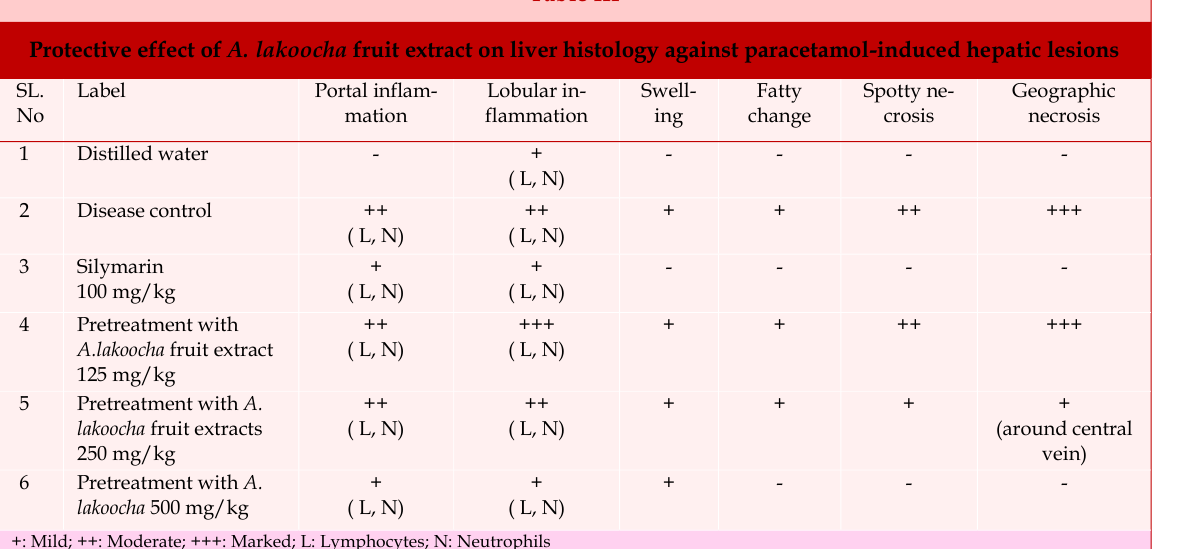
Protective effect of A. lakoocha fruit extract on liver histology against paracetamol-induced hepatic lesions SL.